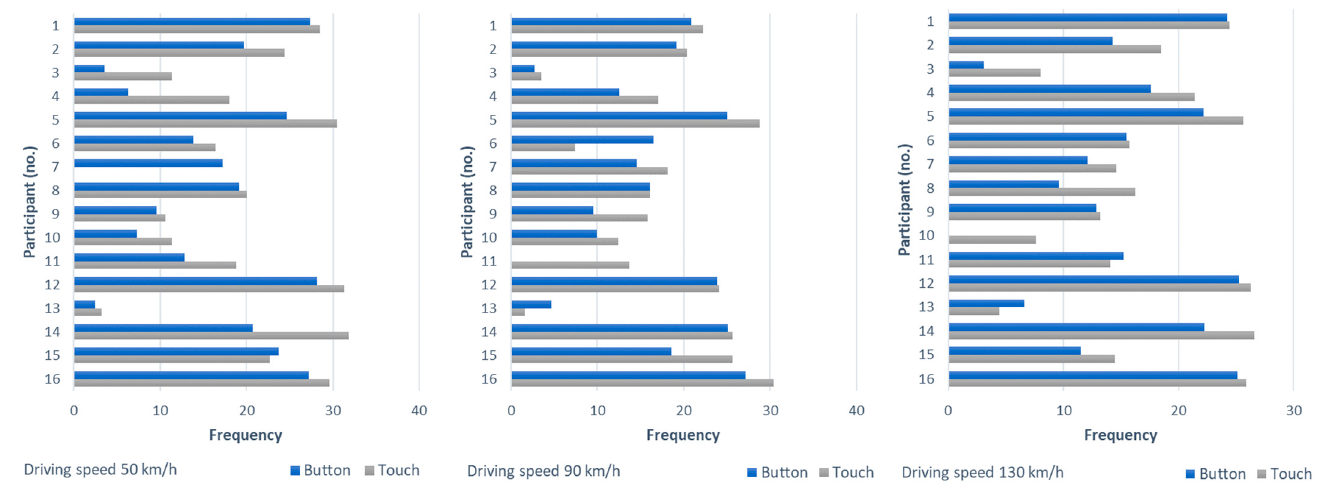
Figure 7. Frequency of saccades (t = 1 s).